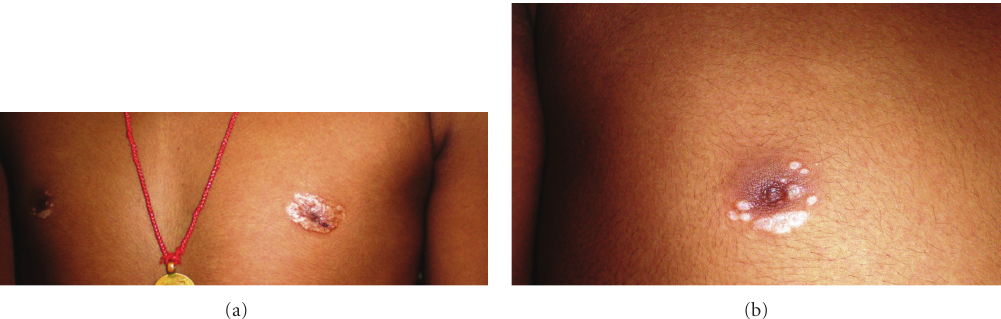
Figure 1: Hypopigmented and depigmented, polygonal atrophic plaques with “delling” about 3 × 3.5 cm on left and 2 cm × 1cm on the right areola. Some papules coalesced to form plaques with comedo like plugs on the surface, more marked and larger on the left areola with minimal scaling over the plaque. A tiny hemorrhagic vesicle over the lesion on left side.